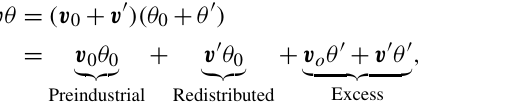
is defined to be zero at time t = t 0 , C anth = (cid:49) C anth